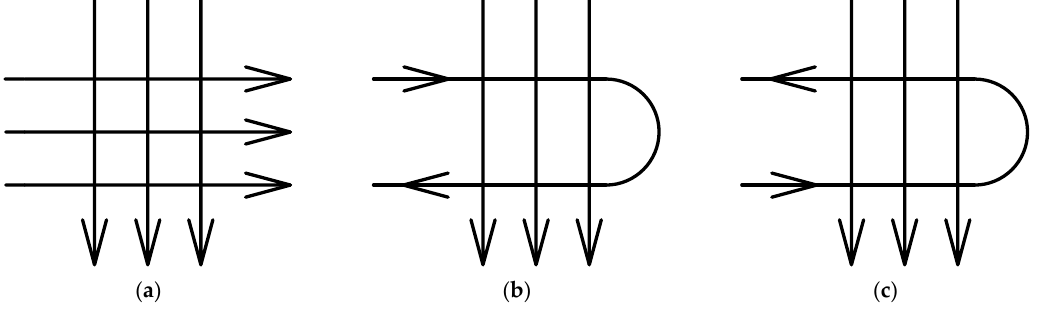
Figure 2. Schematics illustrating different types of a cross flow arrangement: ( a ) pure crossflow, ( b ) two-pass parallel crossflow, and ( c ) two-pass counter-crossflow